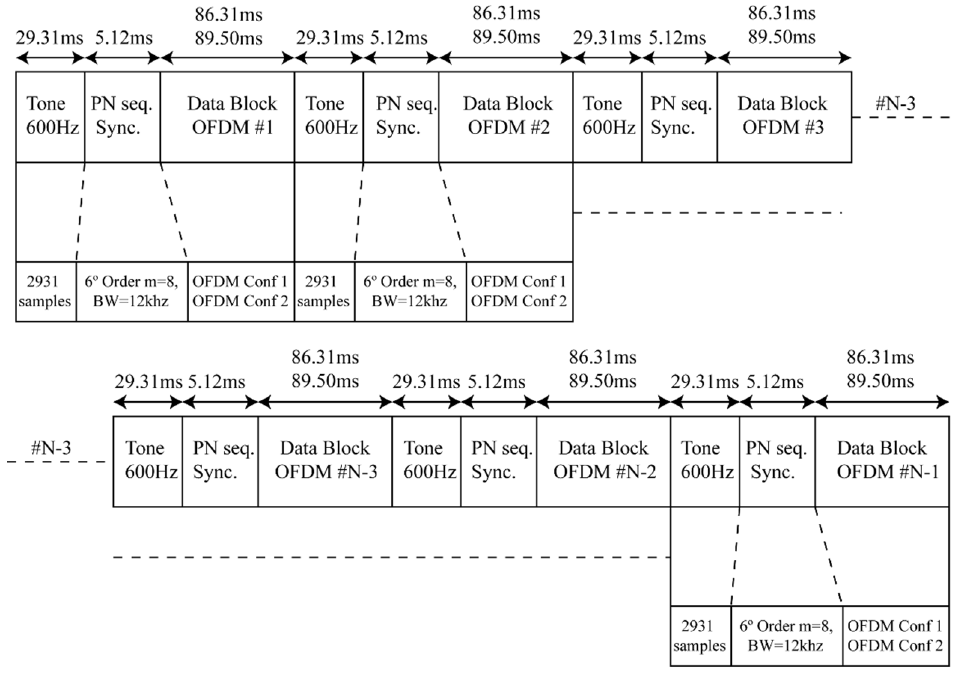
Figure 18. OFDM frame protocol.